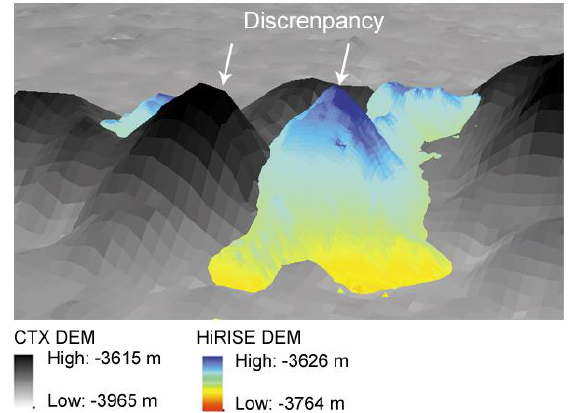
Figure 2. Example of the discrepancy between HiRISE and CTX DEMs in 3D view